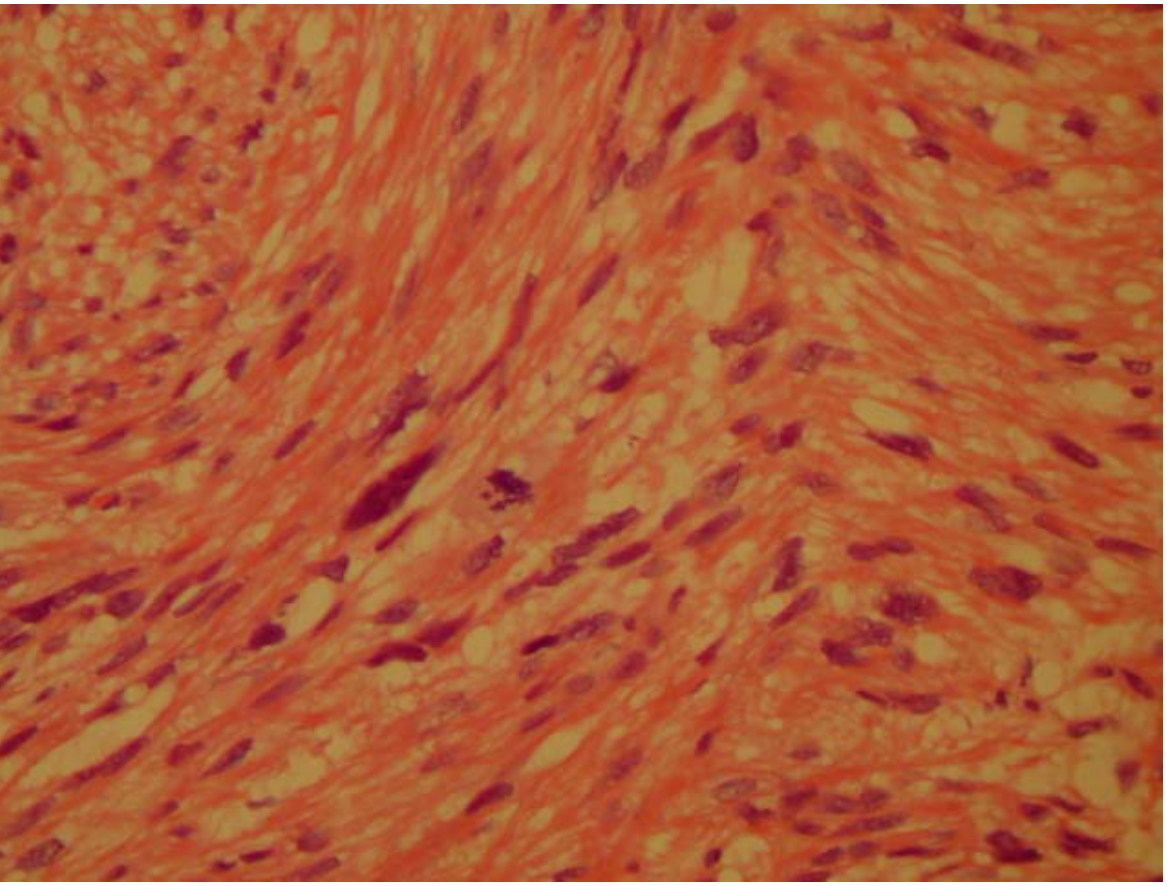
FIGURE 3 . Immunohistochemistry MIB-1 stain of tissue section. MIB-1 is a cell nuclear antigen and a marker for proliferative activity. The stain shows the percentage of cells in cycle is 40% in this case, consistent with a malignant